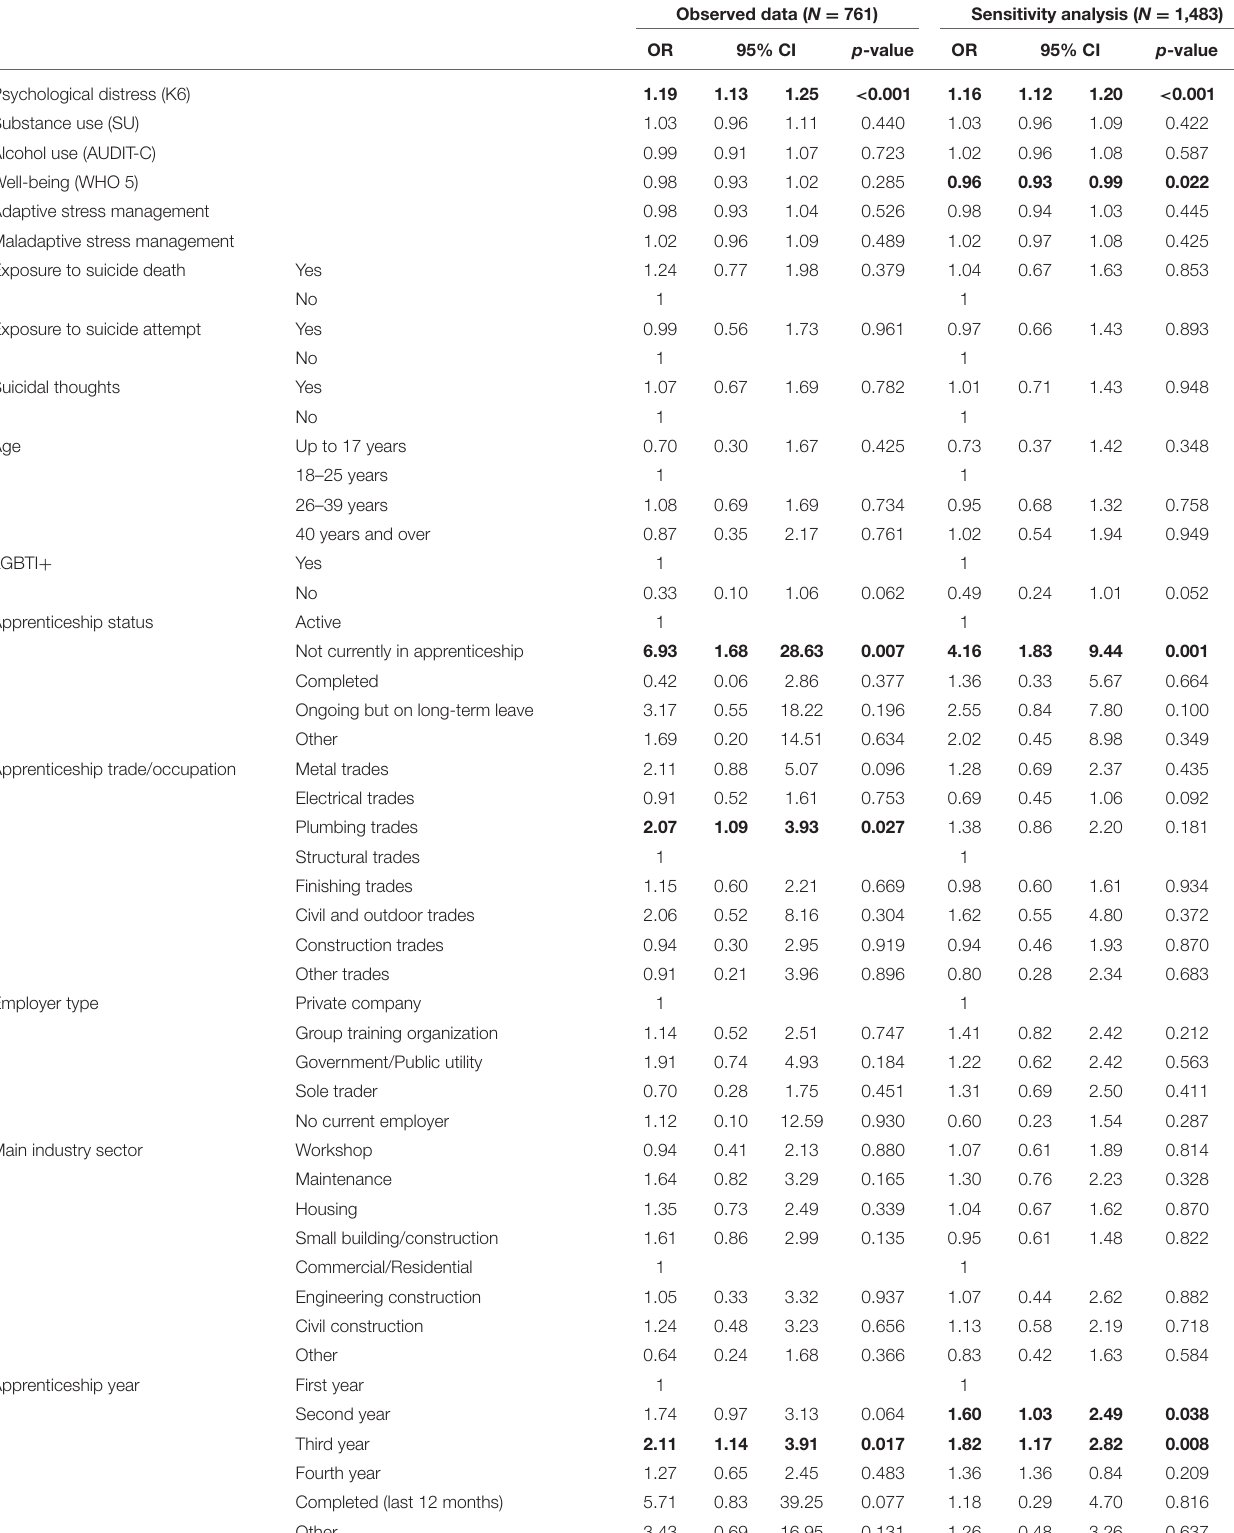
TABLE 7 | Final multinomial logistic regression models of subjective bullying item